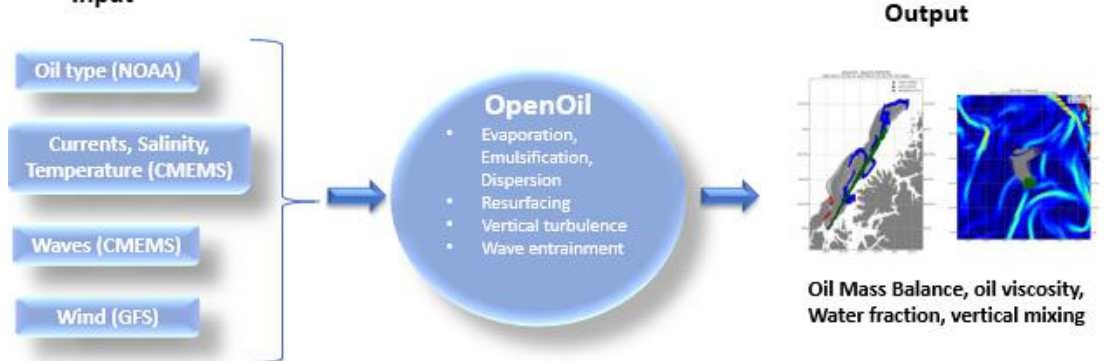
Figure 3. Conceptual flow diagram of the OpenDrift model.